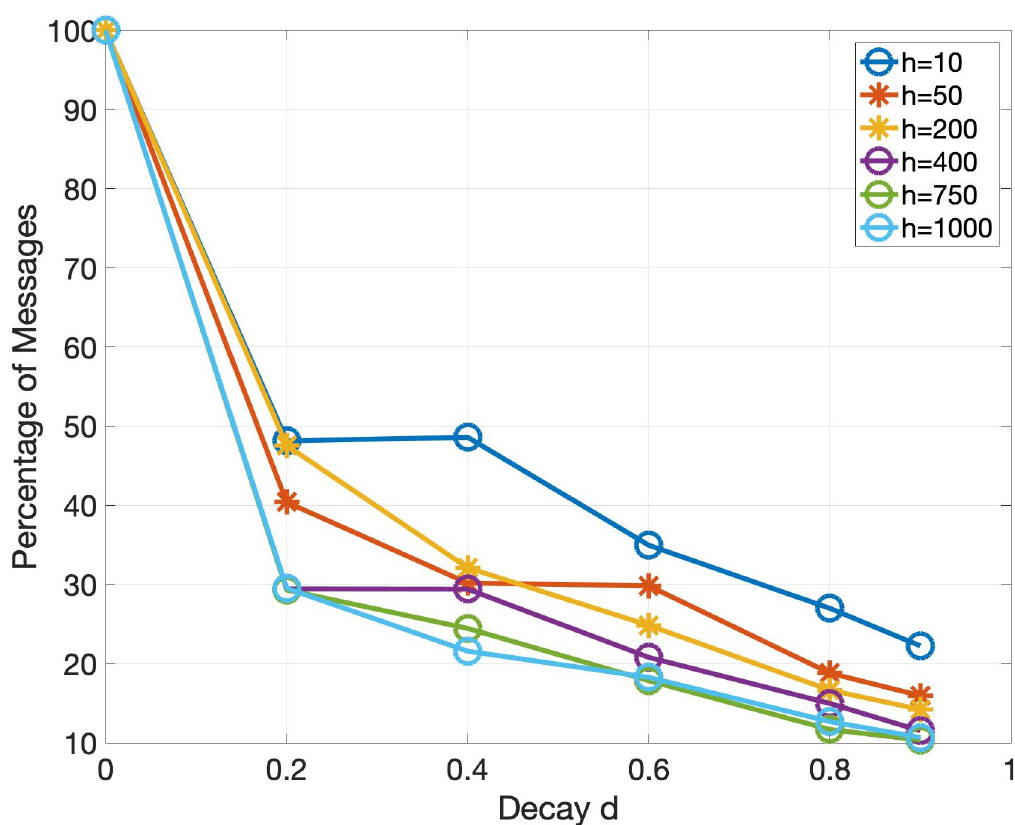
Fig 8. Plot of the percentage of messages in the event-triggered communication solver for various values of horizon h and decay d . Note that a decay of 0 is used to represent 100% of the messages since an event of communication is triggered for this case at every iteration. We see that as the decay and horizon increases, the percentage of messages starts to